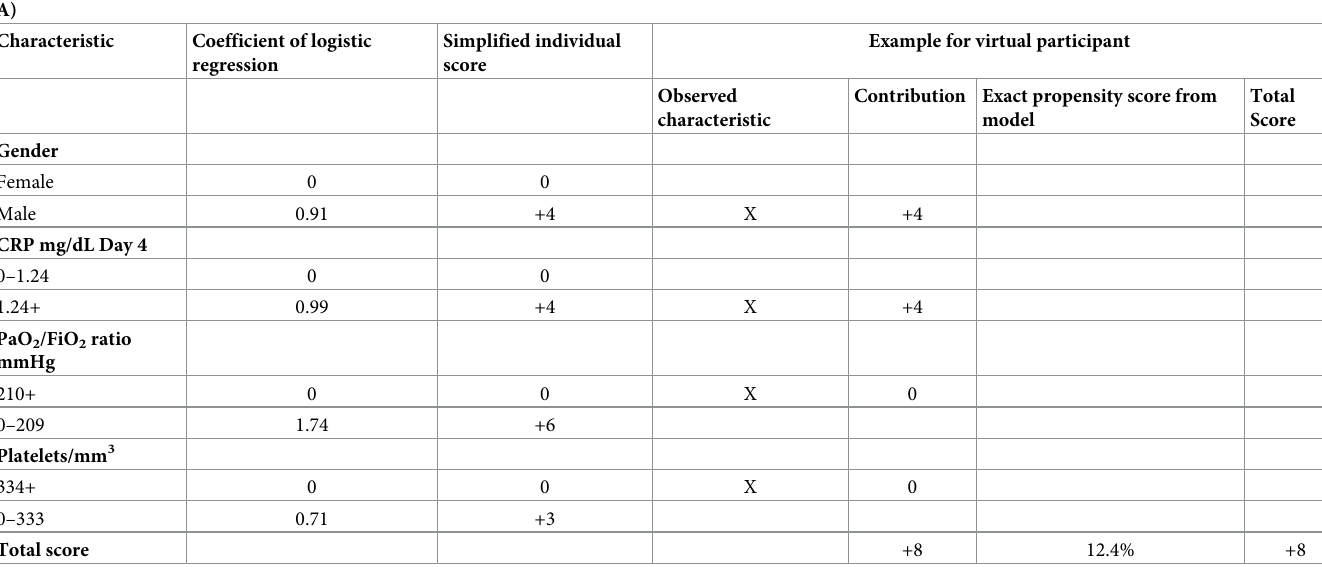
Table 4. Risk score for mechanical ventilation/death on tocilizumab: Exact and simplified risk